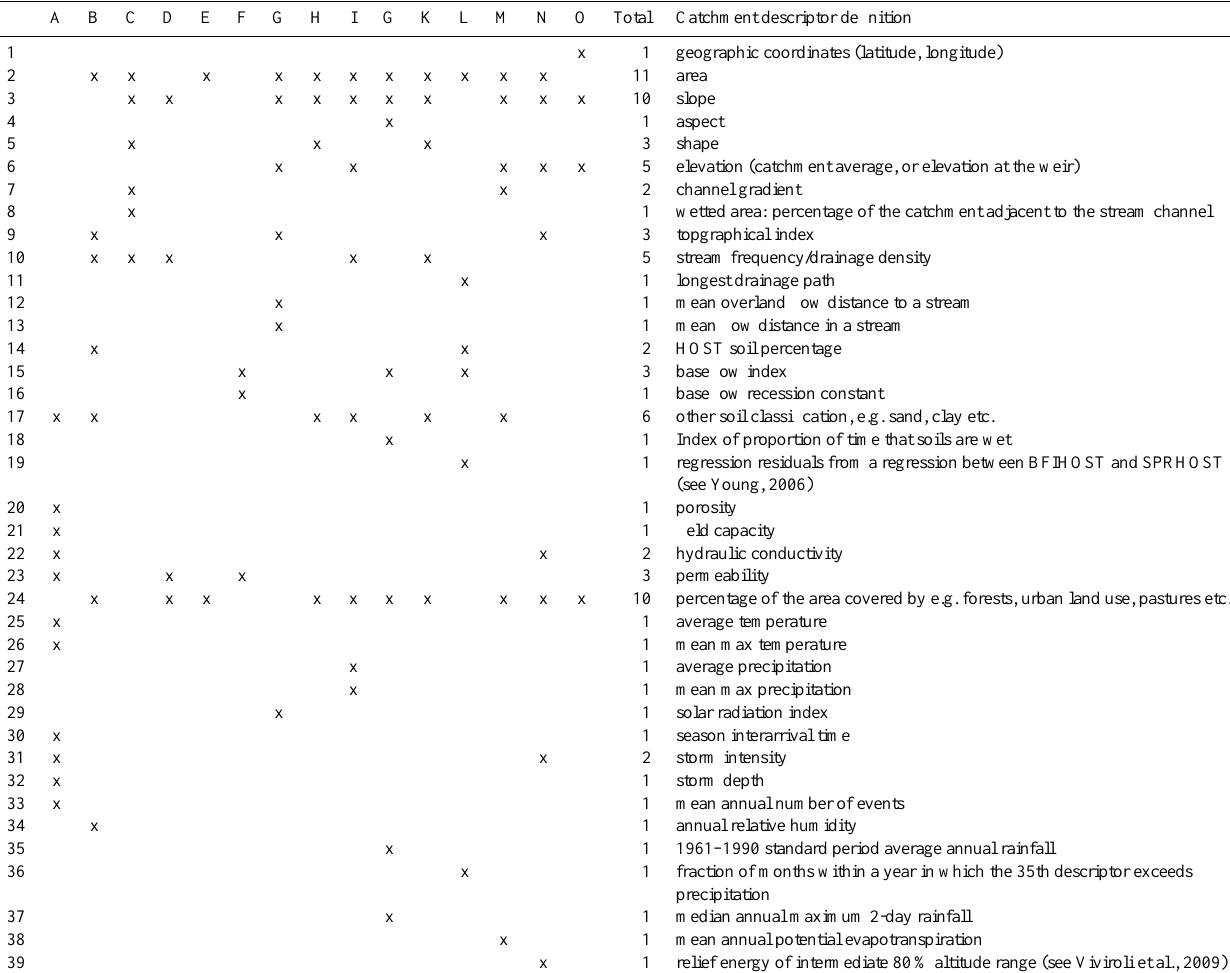
Table 3. CDs that have been used in 15 regression-based regional studies. “Total” refers to the total number of usage of each CD. The top six most frequently used CDs are highlighted in bold. This table needs to be read in conjunction with Table 2 for the 15 studies denoted from A to